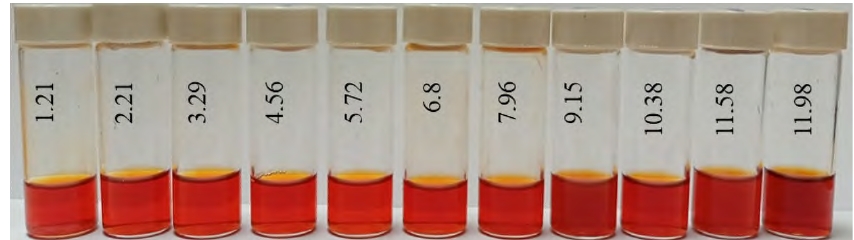
Figure 11. Photo of samples of Se NPs positive sol in various pH media.